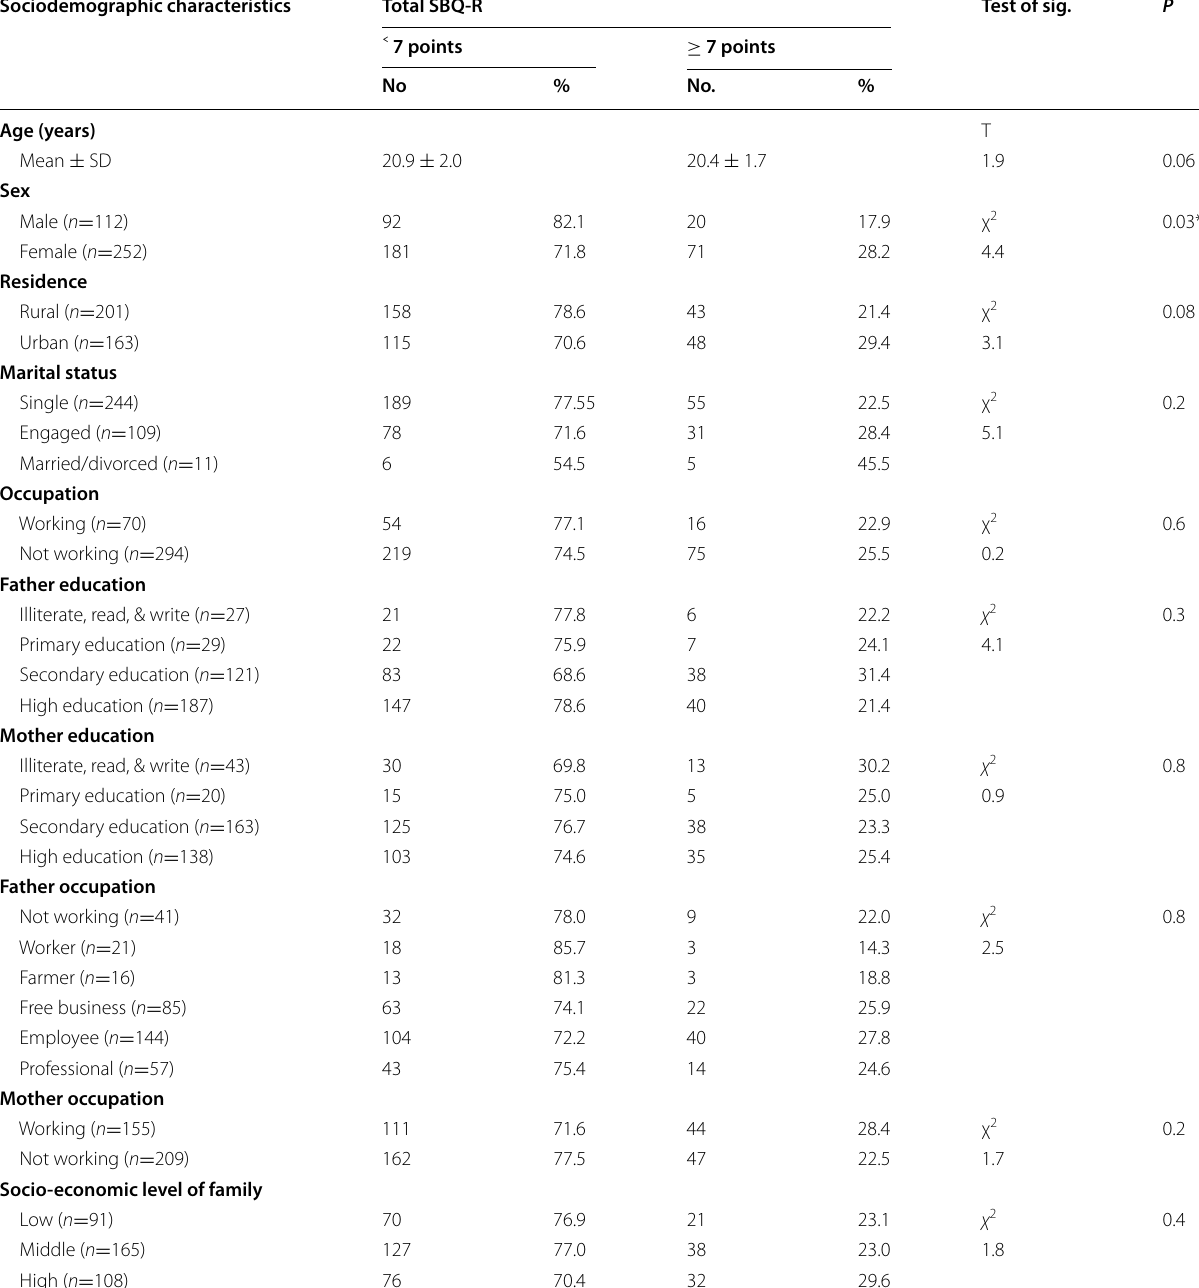
Table 2 Relation between suicidal behaviors and sociodemographic characteristics of the studied youths Sociodemographic characteristics Total SBQ‑R Test of